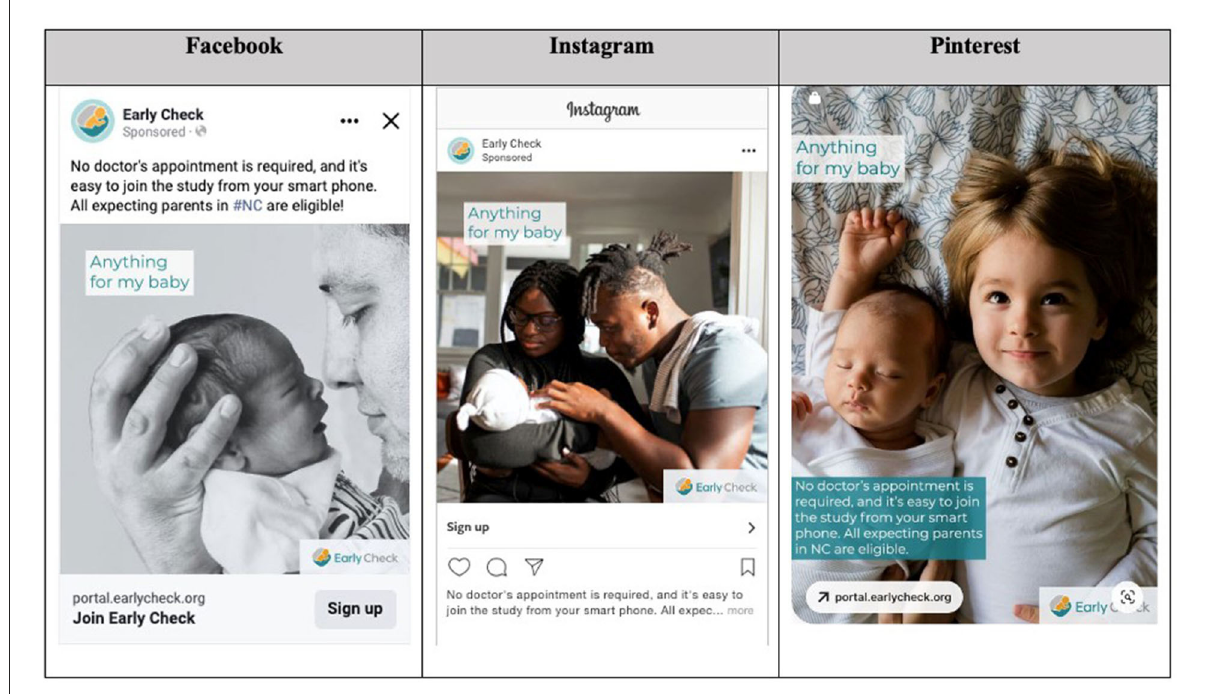
FIGURE1 Examples of advertisements used across all campaigns on Facebook, Instagram, and